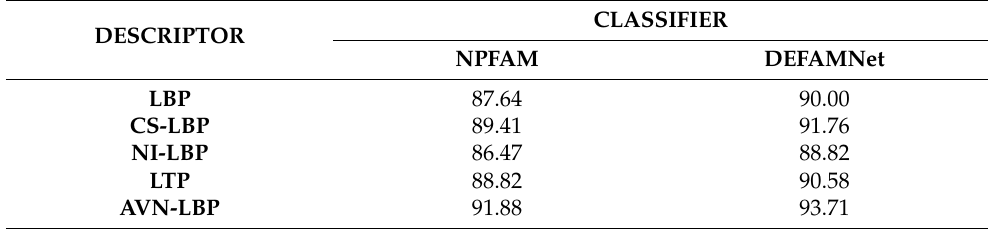
Table 6. Accuracy in percentage achieved on the OASIS database for the top 25 retrieved images.